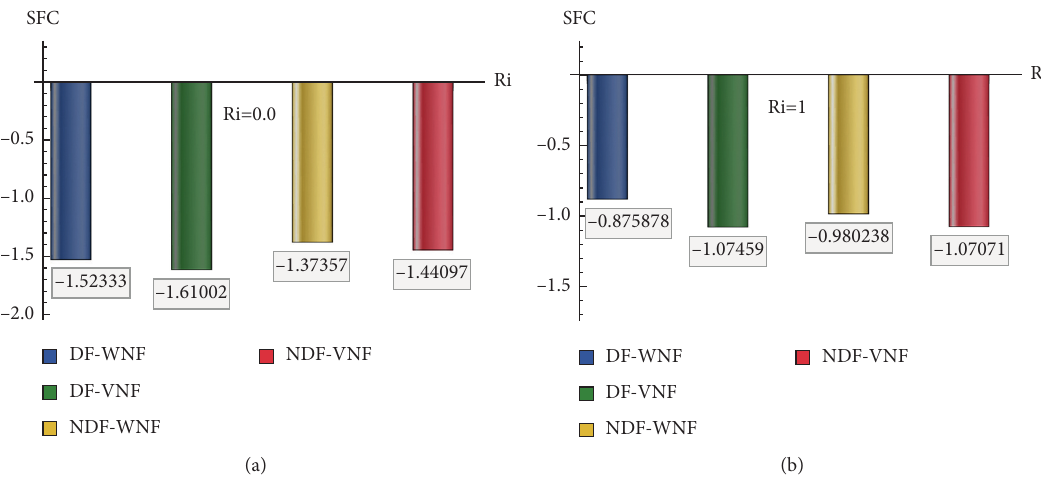
Figure 10: The skin friction coefficient on WNF and VNF on a DFPM and NDFPM with Ri � 0 . 0 (a) and Ri � 1 . 0 (b).